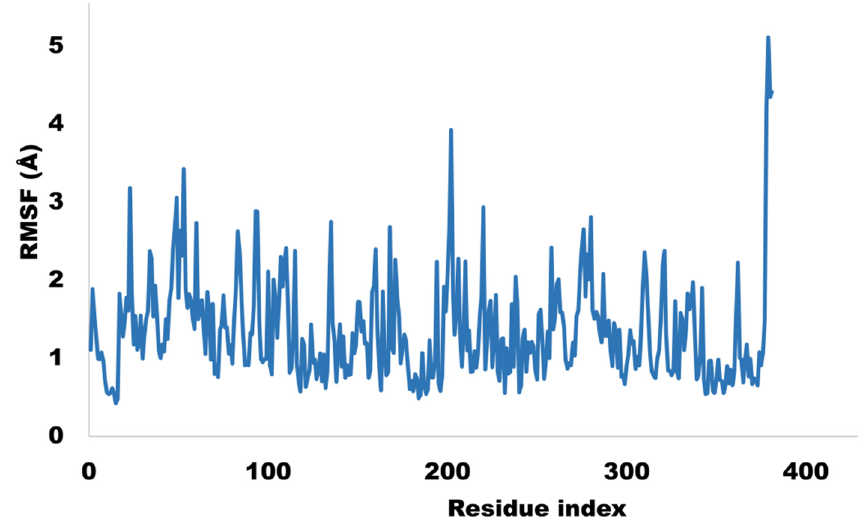
Figure 14. RMSF of Mushroom tyrosinase enzyme.